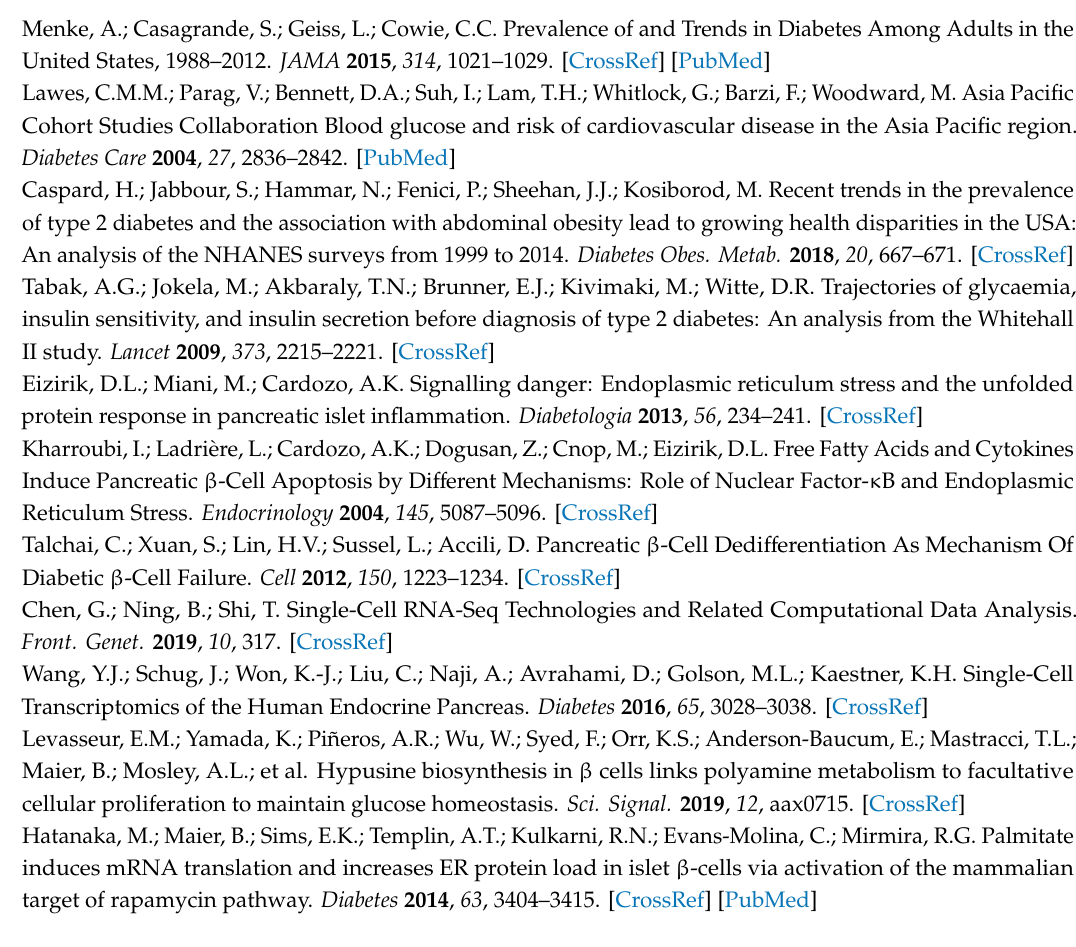
Table S1: Percentage of cells per cluster identified by sc-RNAseq, Figure S1: Genes used for identification of cell clusters, Figure S2: Identification of di ff erentially expressed genes of the major β cell